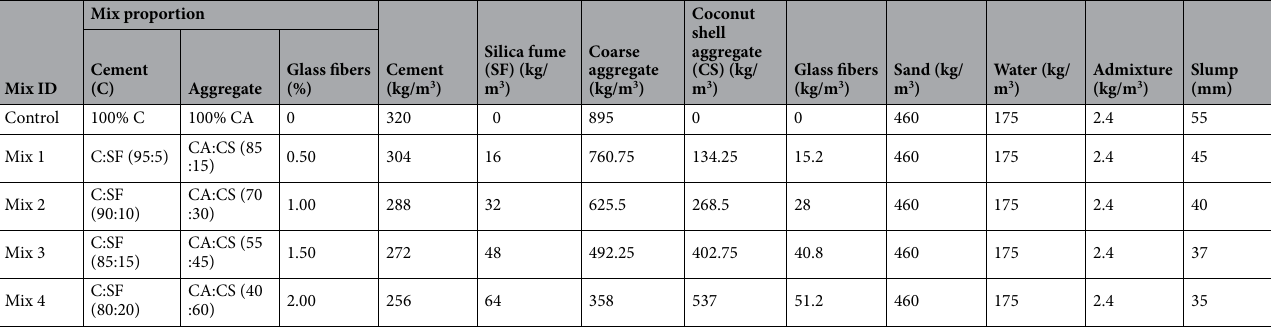
Table 6. Mix proportion of concrete (kg/m 3 ).